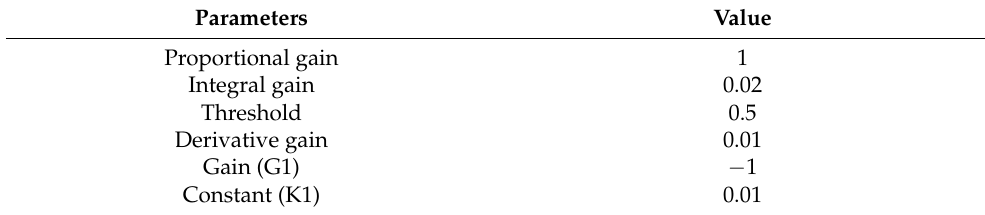
Table 3. Simulation parameters for the proposed